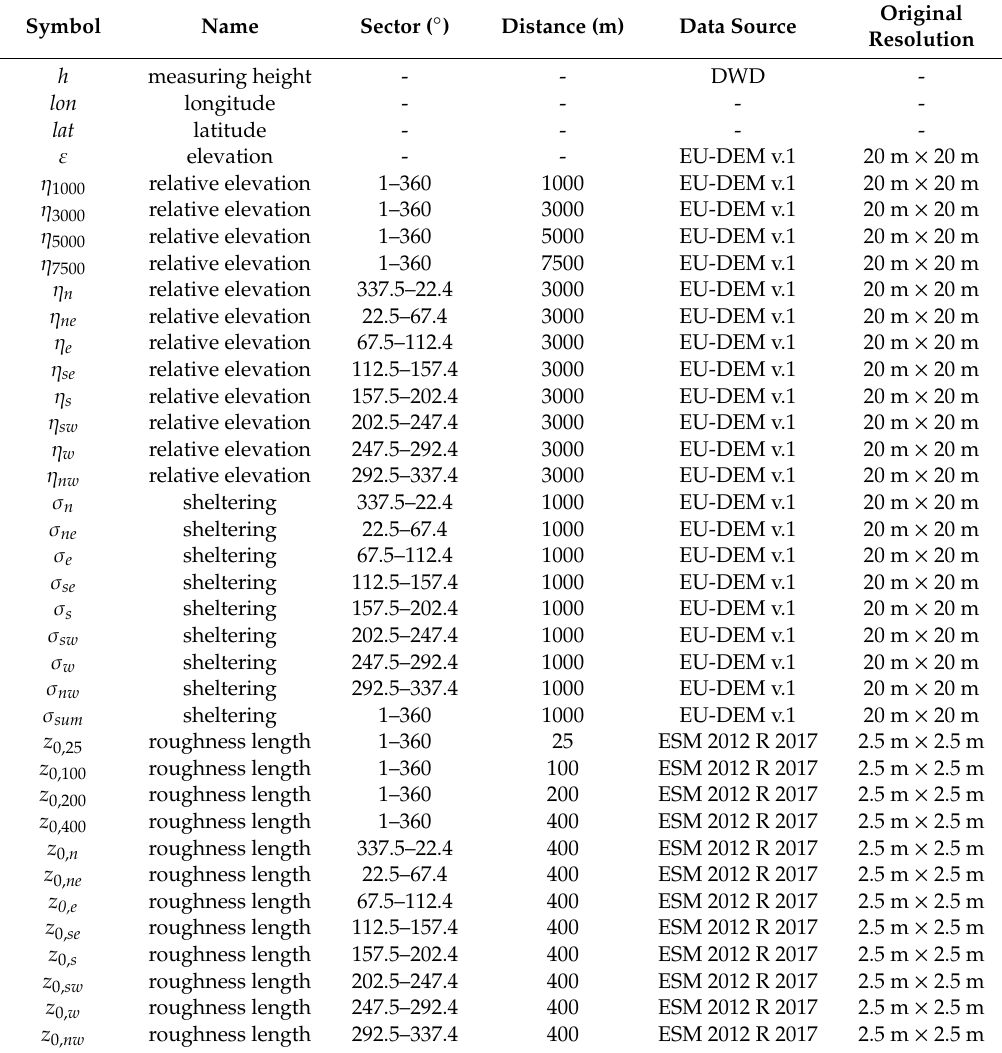
Table 2. Predictor variables (PV) for modeling gust speed ( GS ) with DWD being the German Meteorological Service, EU-DEM is a digital elevation model and ESM is the European Settlement Map.